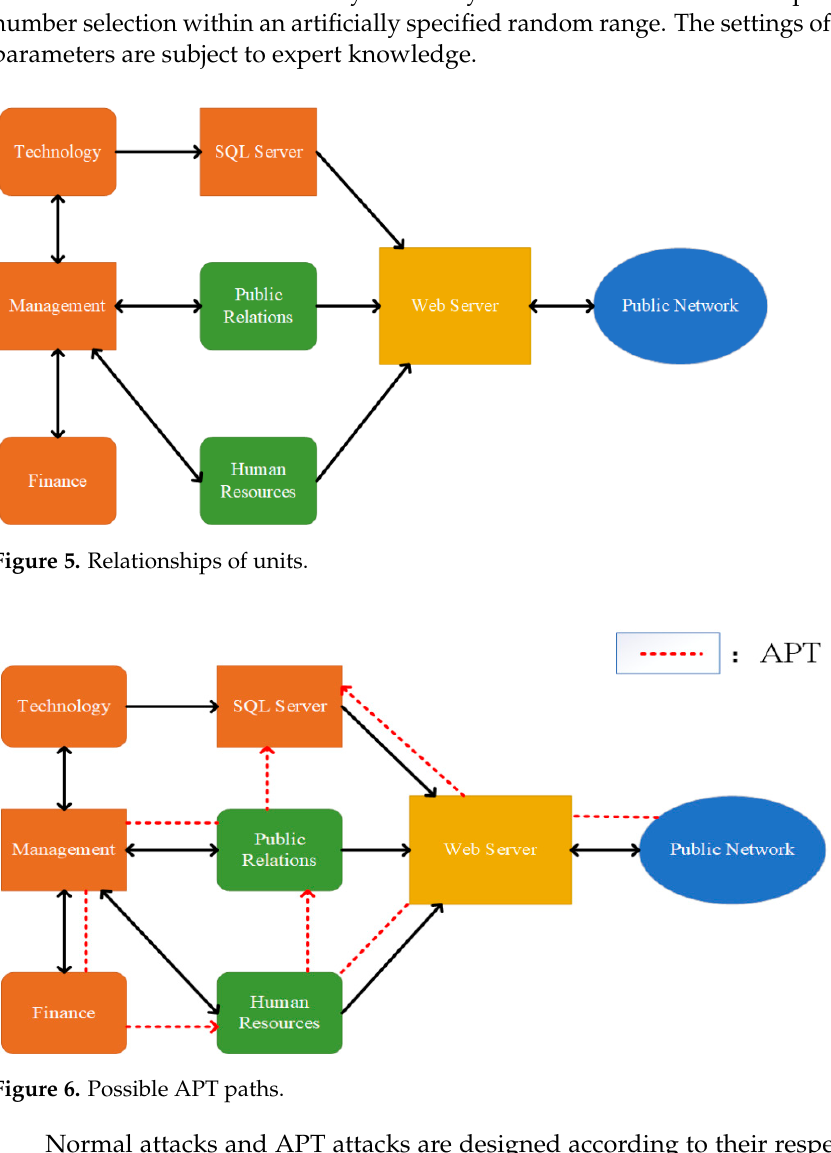
Figure 4. Network structure.